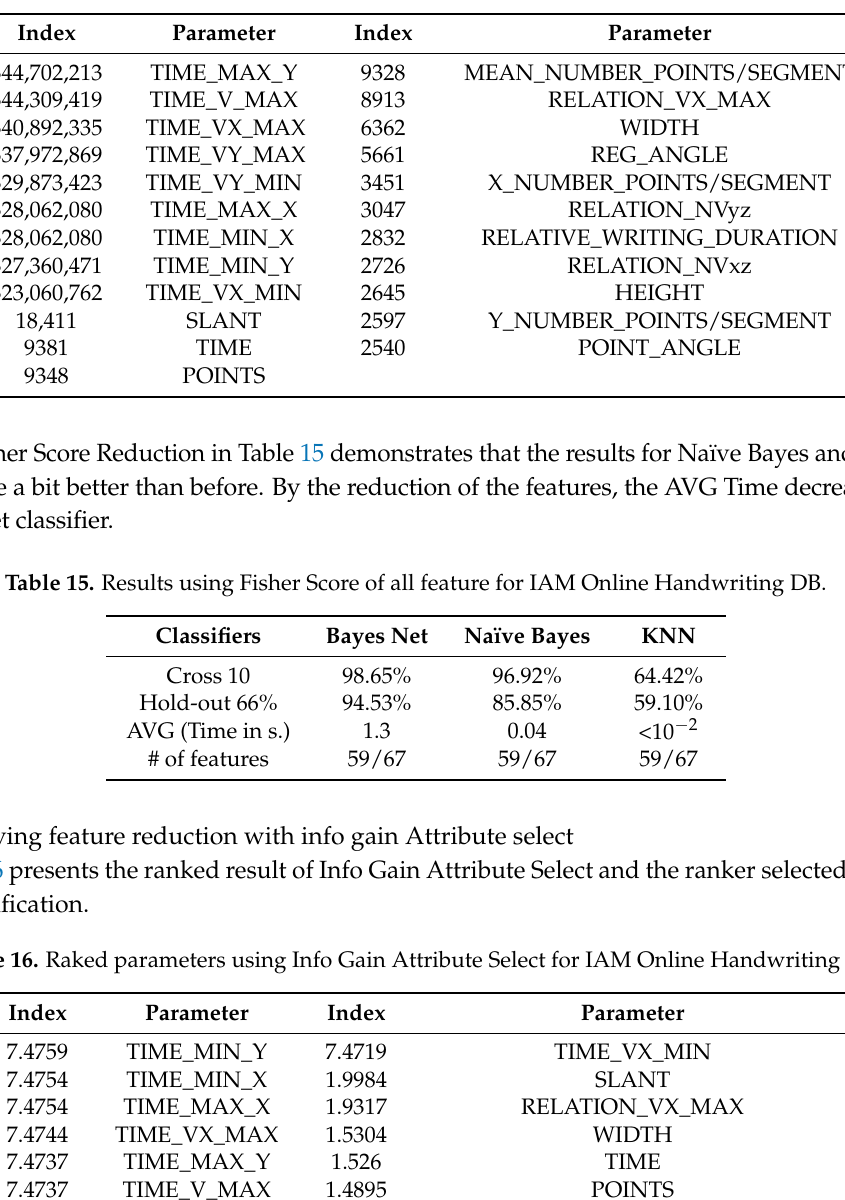
Table 14. Ranked parameters using Fisher Score for IAM Online Handwriting DB.